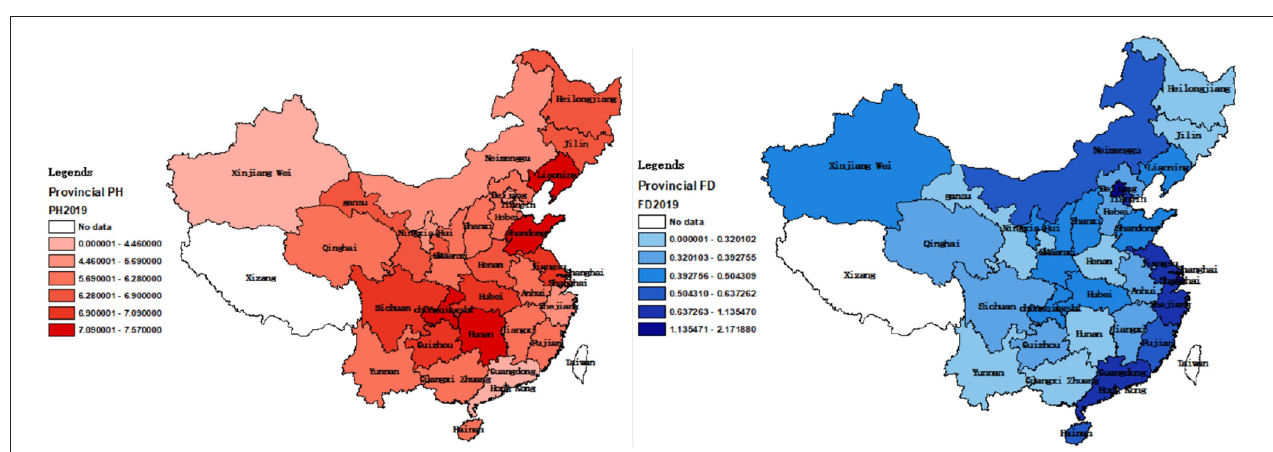
FIGURE 6 | Provincial differences in PH and FD in